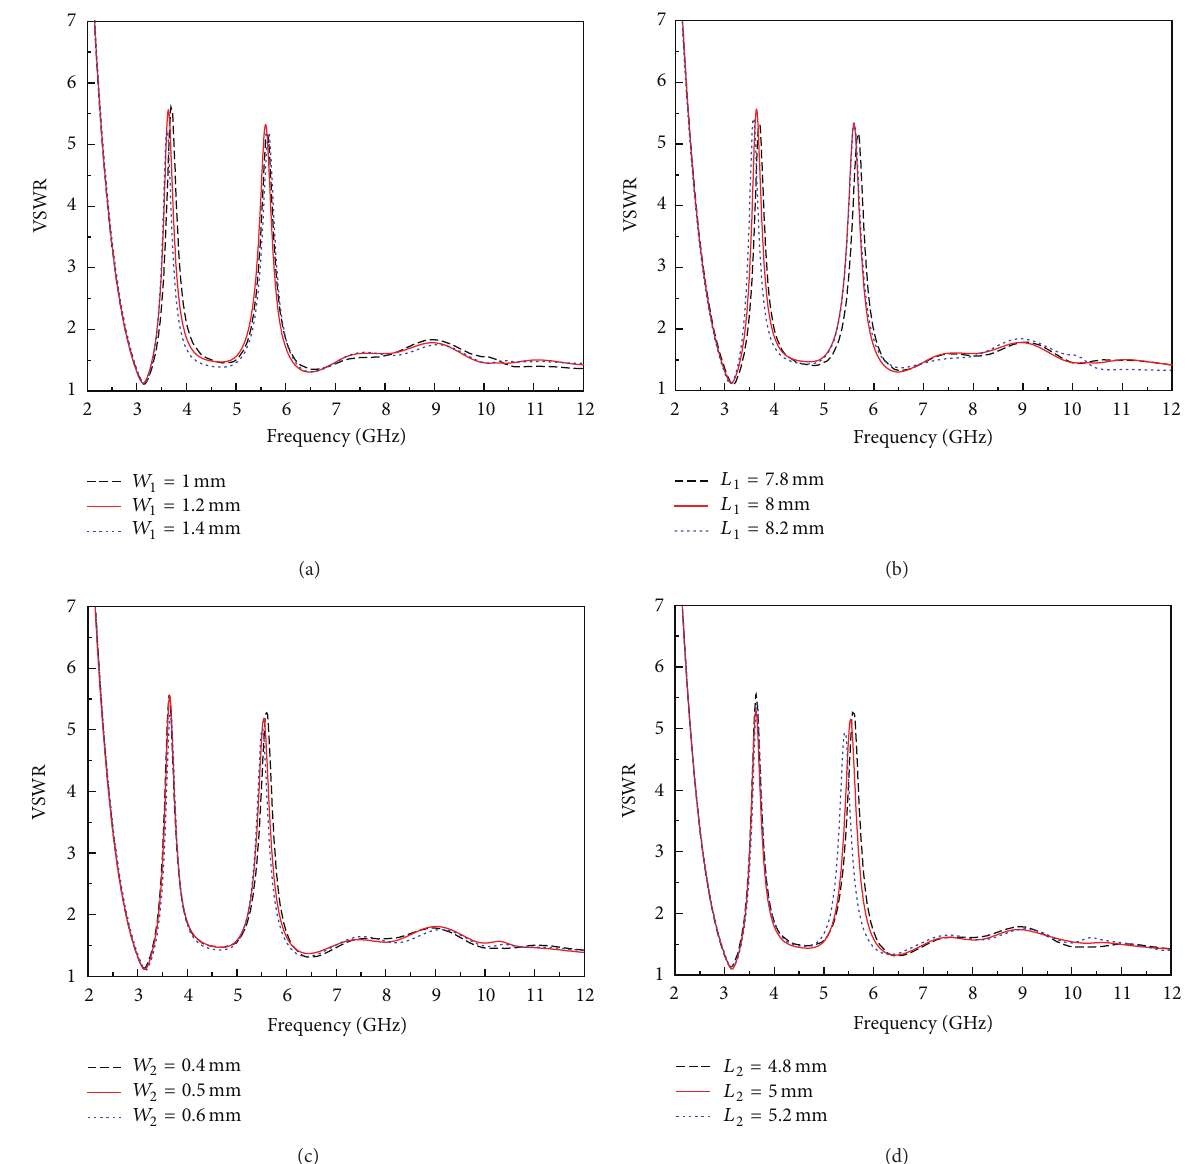
Figure 6: Effects of the parameters of M-EBG on the notched bands: (a) 𝑊 1 , (b) 𝐿 1 , (c) 𝑊 2 , and (d) 𝐿 2 .